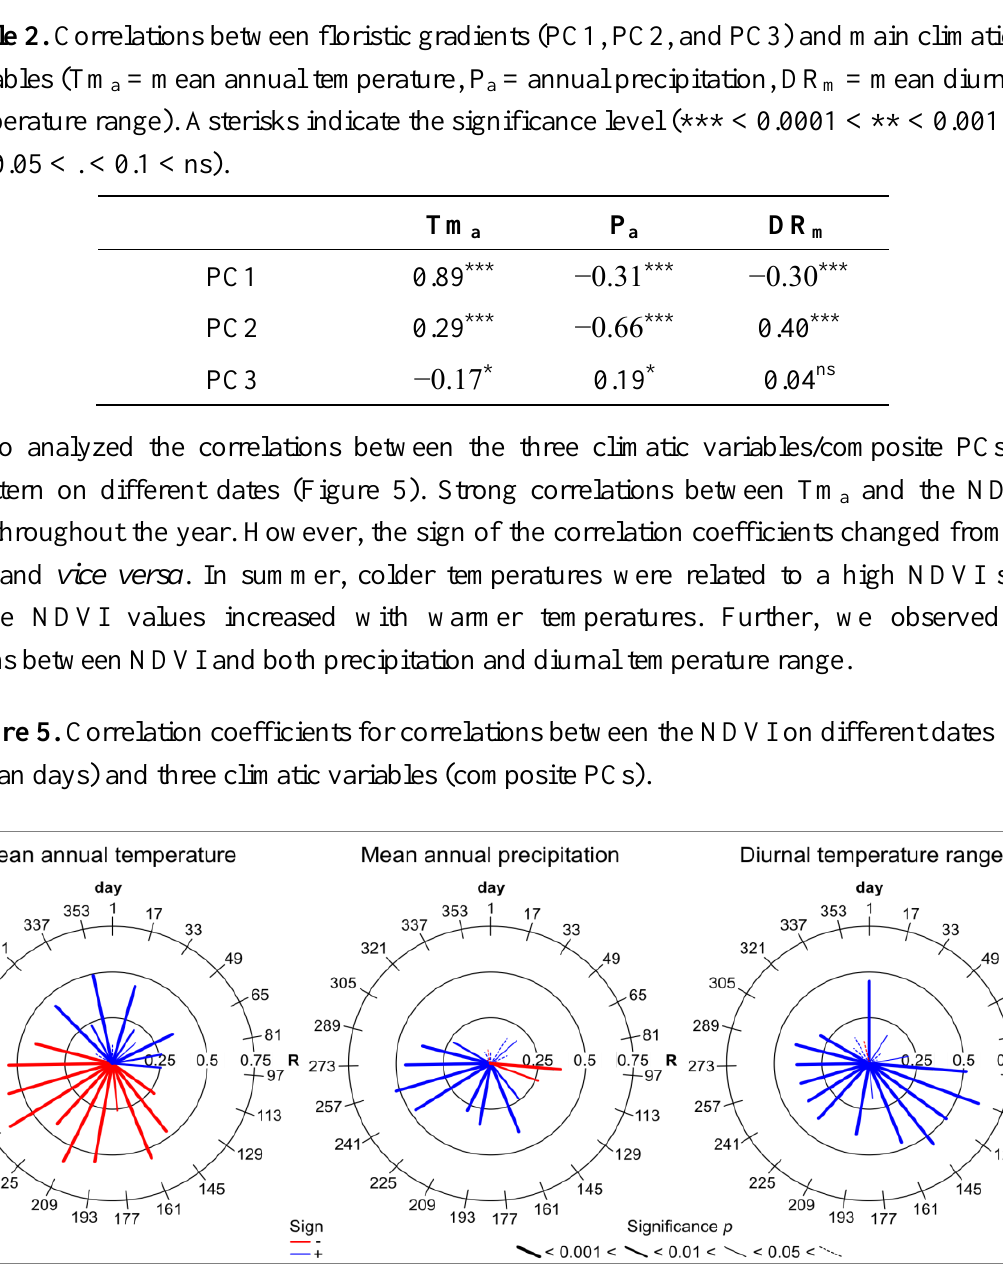
= annual precipitation, DR = mean diurnal a m